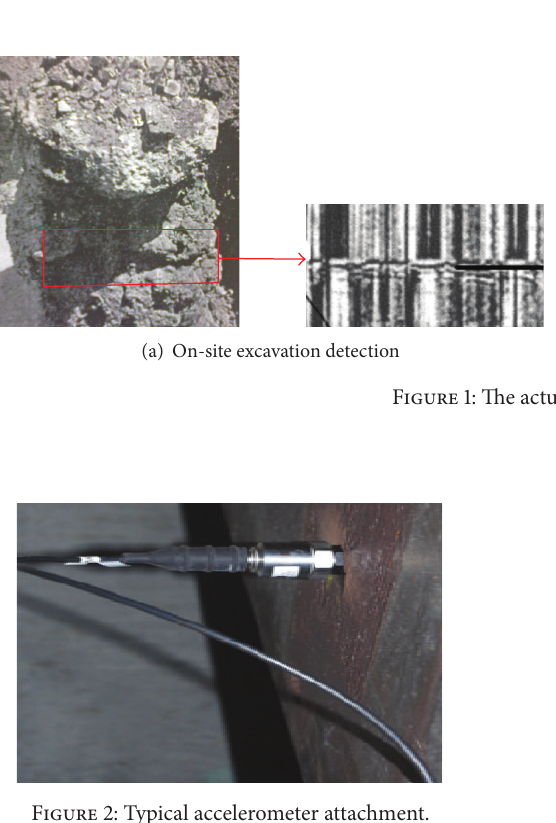
Figure 2: Typical accelerometer attachment.